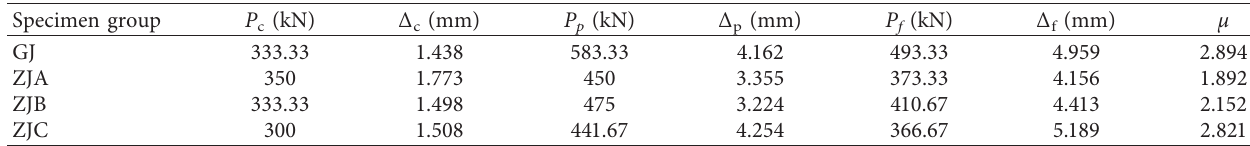
Figure 9: Failure patterns of specimens ZJC: (a) ZJC1, (b) ZJC2, and (c) ZJC3. Table 3: Test average and calculation results.